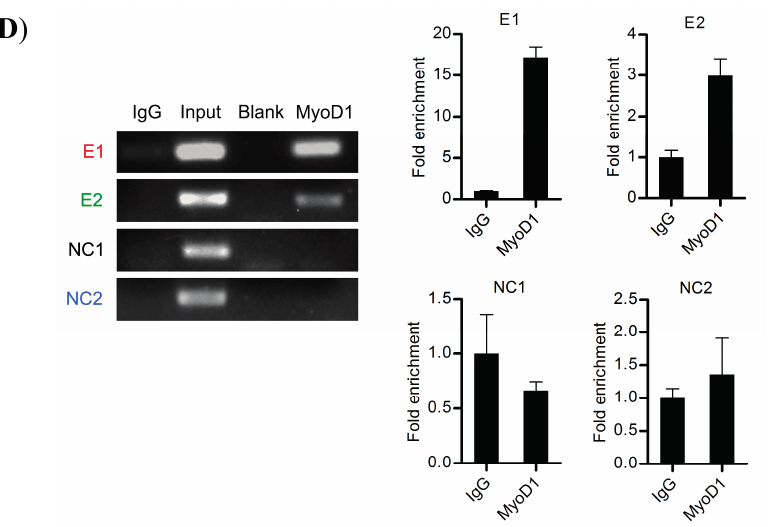
Figure 4. MyoD1 improves the activity of FIT1 promoter and binds to the canonical E-box1 site during C2C12 myogenesis. ( A ) Overexpression of MyoD1 greatly increased FIT1 promoter activity in C2C12 myotubes. The pcDNA3.1 plasmid was used as a negative control. Data are the means ± SD ( n = 3). *** p < 0.001 relative to the negative control (2-tailed student’s t -test); ( B ) knockdown of MyoD1 by siRNA in C2C12 myotubes dramatically decreased the activity of FIT1 promoter. The NC siRNA was used as a negative control. Data are shown as the means ± SD ( n = 3). ** p < 0.01; *** p < 0.001 relative to the negative control (2-tailed student’s t -test). Black bar denotes experiment group; gray bar denotes control group; ( C ) the relative positions of the primers used in ChIP qPCR reactions. The relative positions of each primer pair are indicated in arrows with the same color. Primer sets of E1 and E2 were used to amplify E-box1 and E-box2 regions specific to FIT1 promoter, respectively. As negative controls, primer sets of NC1 were used to amplify the exon1 region (without E-box); primer sets of NC2 were used to amplify the exon2 region (with one E-box), which was not expected to interact with MyoD1; ( D ) the relative enrichments of either E-box region in FIT1 promoter by ChIP. Input served as the internal control and data were normalized to IgG by ∆∆ C t method. Data are indicated with the means ± SD ( n = 3). A representative image was shown for each primer set. Total chromatin was used as the input. IgG was used as a negative control; blank indicated no template in the PCR